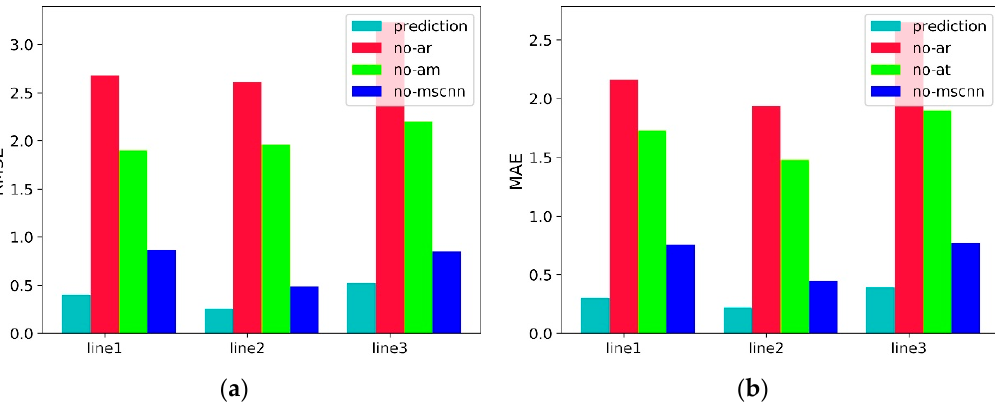
Figure 14. Ablation experiments with RMSE in ( a ) and MAE in ( b ). The values of line 1 and line 3 are 10 − 3 , and line 2 is 10 − 2 .